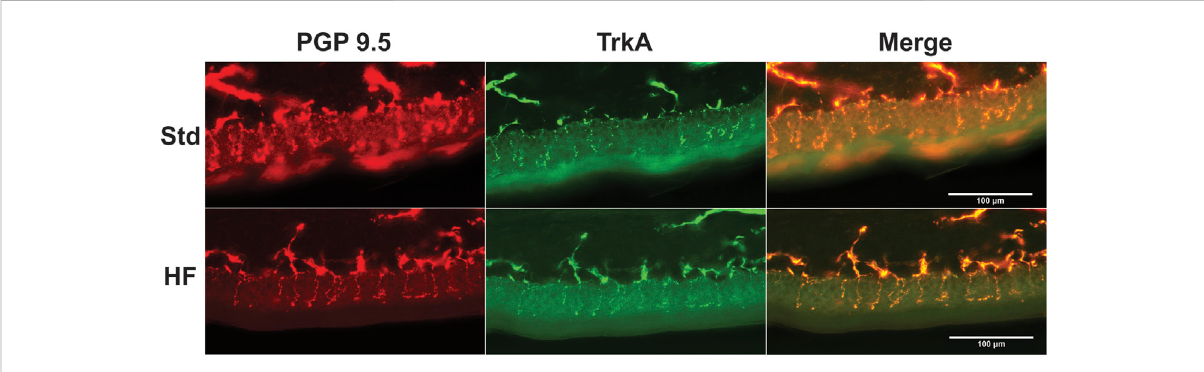
Representative ImagesofEpidermalInnervation.Fluorescent images show nerve fi bersfor Std(toppanel) and HF(lower panel) after 8weeks of dieteray intervention. Nerve fi bers that crossed the epidermal/dermal border were quanti fi ed and expressed as fi bers per mm. Anti-PGP 9.5 (red) labeled all nerve fi bers and anti-TrkA (green) labeled TrkA nerve fi